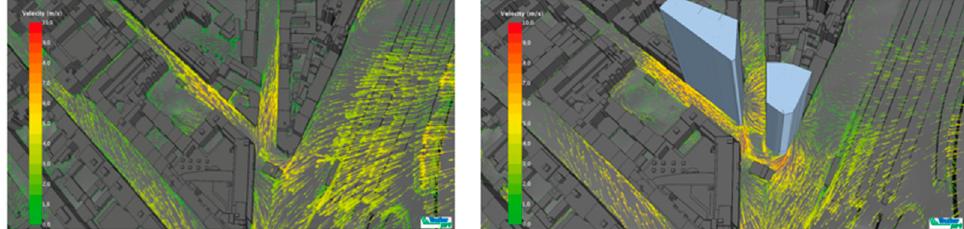
Figure 16. Changes in wind speed and direction for south-east wind direction for base case ( left ) and the high-rise buildings densification scenario ( right ).